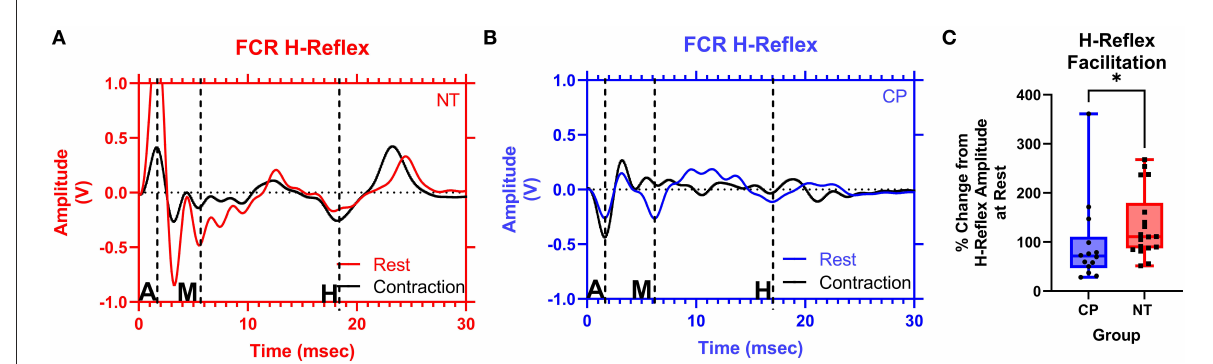
FIGURE4 The facilitation of the flexor carpi radialis H-reflex is lower in adults with cerebral palsy than in neurotypical adults. Raw averaged flexor carpi radialis (FCR) H-waves and M-waves during rest (in red and blue, respectively) and during voluntary contraction (in black) for an exemplary NT adult control (A) and an adult with CP (B) are shown. The exemplary subjects were chosen based on their similarity to the means of the respective groups. Inspection of (A,B) , shows that the H-wave does not appreciably change for the adult with CP, while it is altered during the muscle contraction for the NT control. EMG amplitude from the FCR muscle is shown on the y-axis and time (ms) is denoted on the x-axis, with 0ms defined as the onset of the stimulus artifact. M, M-wave; H, H-wave; A, stimulus artifact. (C) Box-and-whisker plots of the group Hact:Hrest ratios. As shown, the Hact:Hrest ratios were statistically smaller in the adults with CP, when compared with the NT controls. * Indicates P < 0.05.